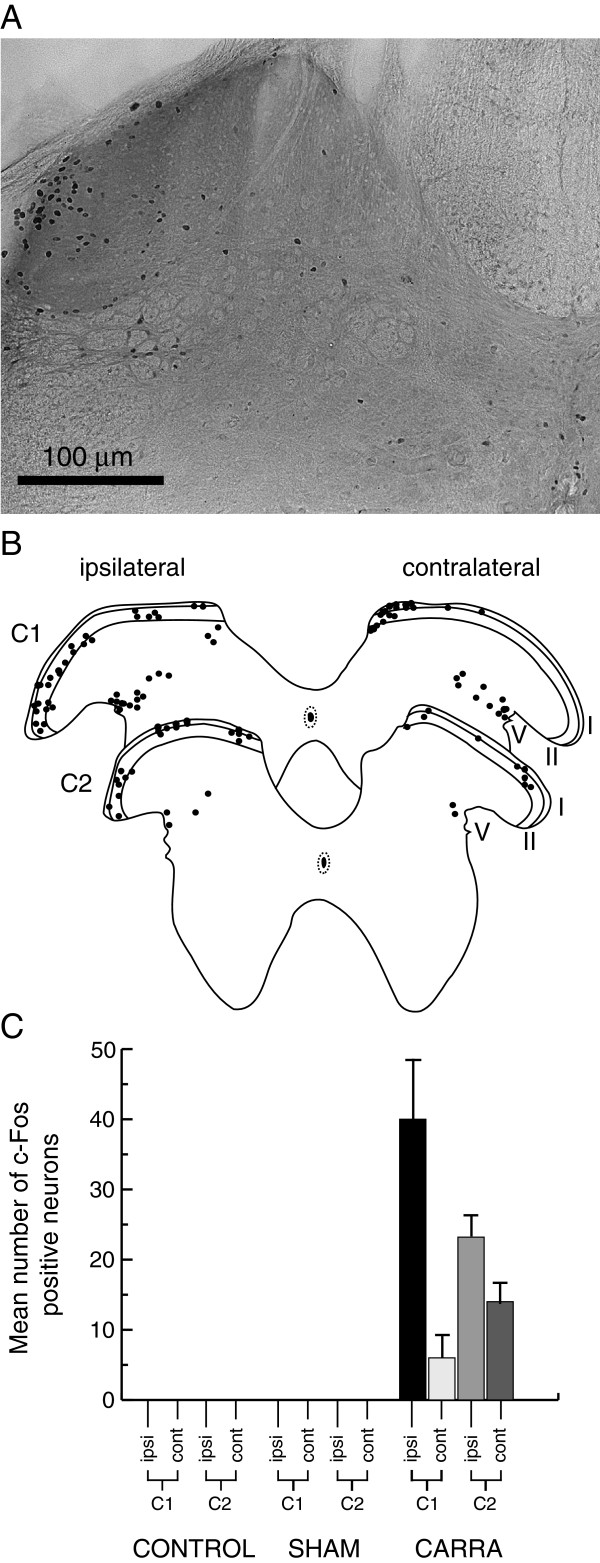
Neck muscle inflammation activates upper-cervical dorsal horn neurons. A. Representative image of a transverse spinal cord section (C2 level) from a carrageenan-injected animal showing cFos labelling in the ipsilateral dorsal horn. Note, labelled neurons are concentrated in the superficial dorsal horn with a lateral bias. B. Maps showing group data from carrageenan-injected animals. The location of cFos labelled neurons have been collapsed onto standardised C1 and C2 templates (adapted from [13]). C. Graph comparing mean number of cFos positive neurons in control, sham, and carrageenan-injected animals. Data are separated into ipsilateral and contralateral staining across spinal levels C1 and C2.